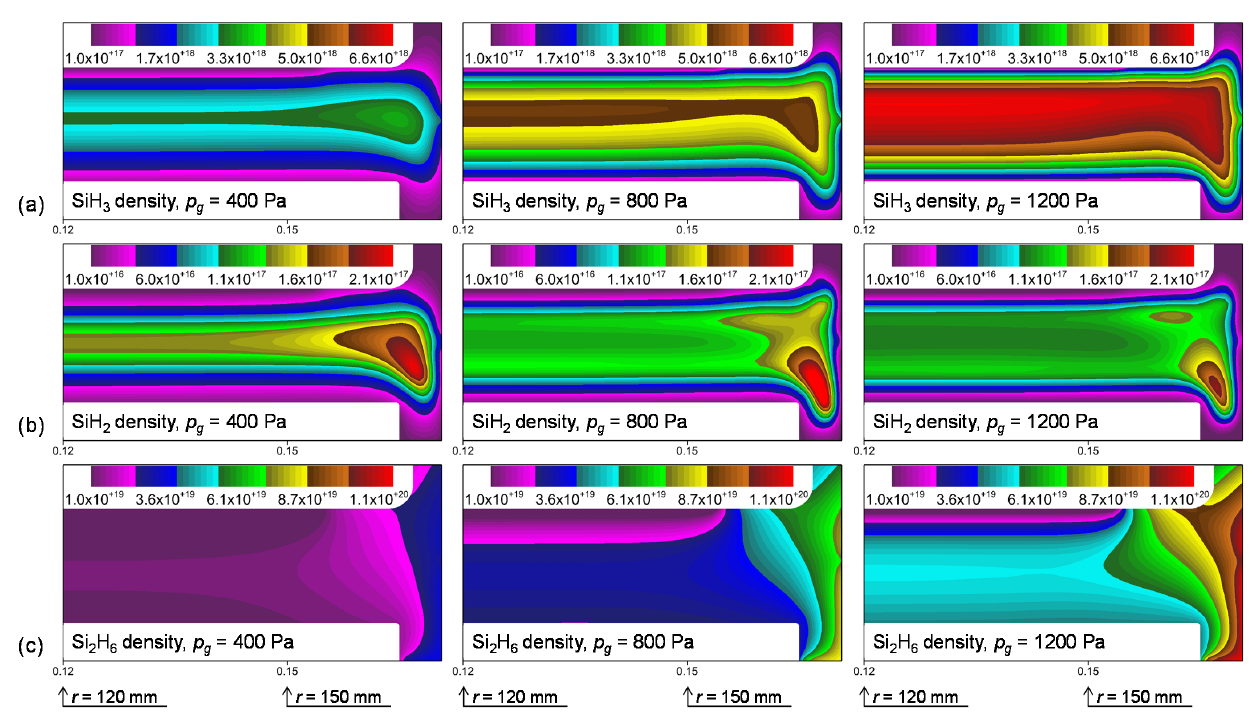
Figure 11. Effects of the gas pressure ( p g = 400, 800 and 1200 Pa) on the spatial density distribution of neutral species. Contour plots for the spatial profiles of the time-averaged ( a ) SiH 3 density (m − 3 ), ( b ) SiH 2 density (m − 3 ) and ( c ) Si 2 H 6 density (m − 3 ) for r ≥ 120 mm.